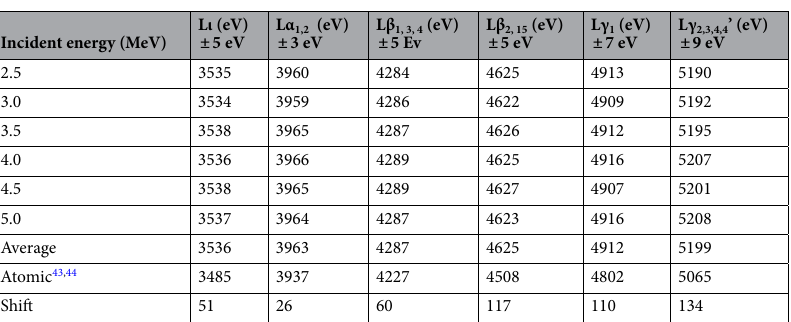
Table 1. The energies of I L-subshell X-rays produced by I 22+ ions with various incident energies impacting on Fe